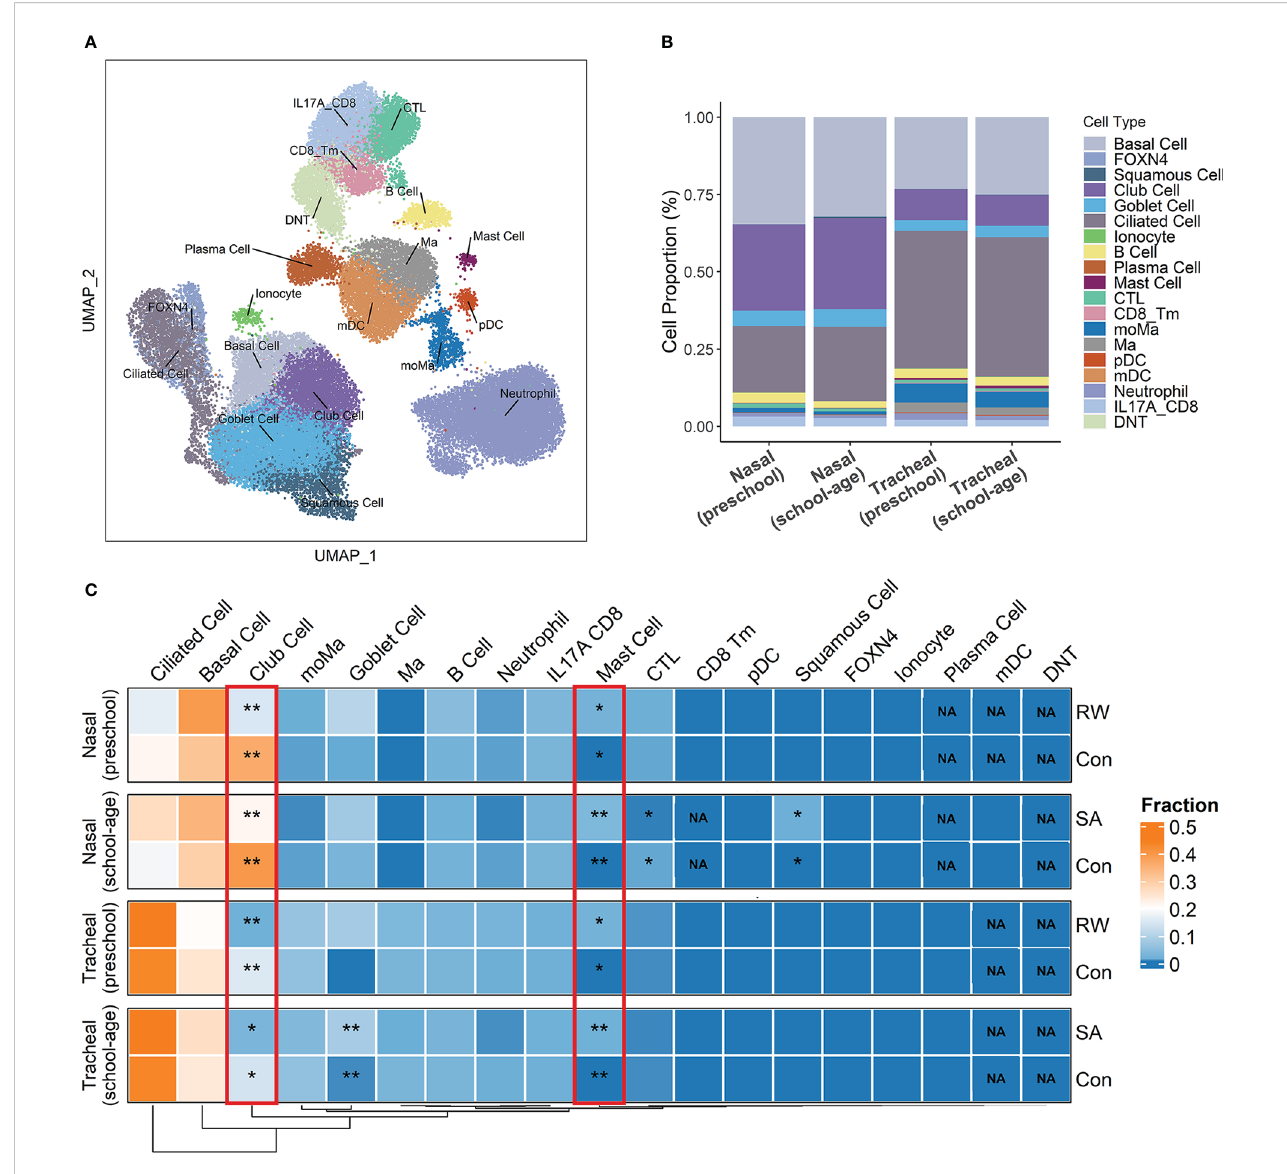
FIGURE 3 Deconvolution of airway transcriptome data to infer critical cell components shared by RW and SA. (A) Overall cell-type composition of 38 399 cells from 18 healthy children visualized using UMAP. CD8_Tm, memory CD8+ T cells; CTL, cytotoxic T cells; DNT, double-negative T cells; FOXN4, FOXN4+ cells; IL-17A_CD8, IL-17A-expressing CD8+ T cells; mDC, myeloid dendritic cells; Ma, macrophages; moMa, monocyte-derived macrophages; pDCs, plasmacytoid dendritic cells. (B) Histogram displaying proportion of each cell type in preschool and school-age subjects across nasal and tracheal samples. (C) Heatmap of proportion of each cell type across upper and lower airways of RW, SA and healthy controls inferred by cell deconvolution analysis. NA indicates P- value could not be calculated because corresponding cellular components were not detected by CIBERSORTx. Statistical signi fi cance was assessed using Wilcoxon rank-sum test. Asterisks indicate P -values for RW or SA versus control. * P < 0.05, ** P < 0.01. Con, control; NA, not applicable; RW, recurrent wheezing; SA, school-age